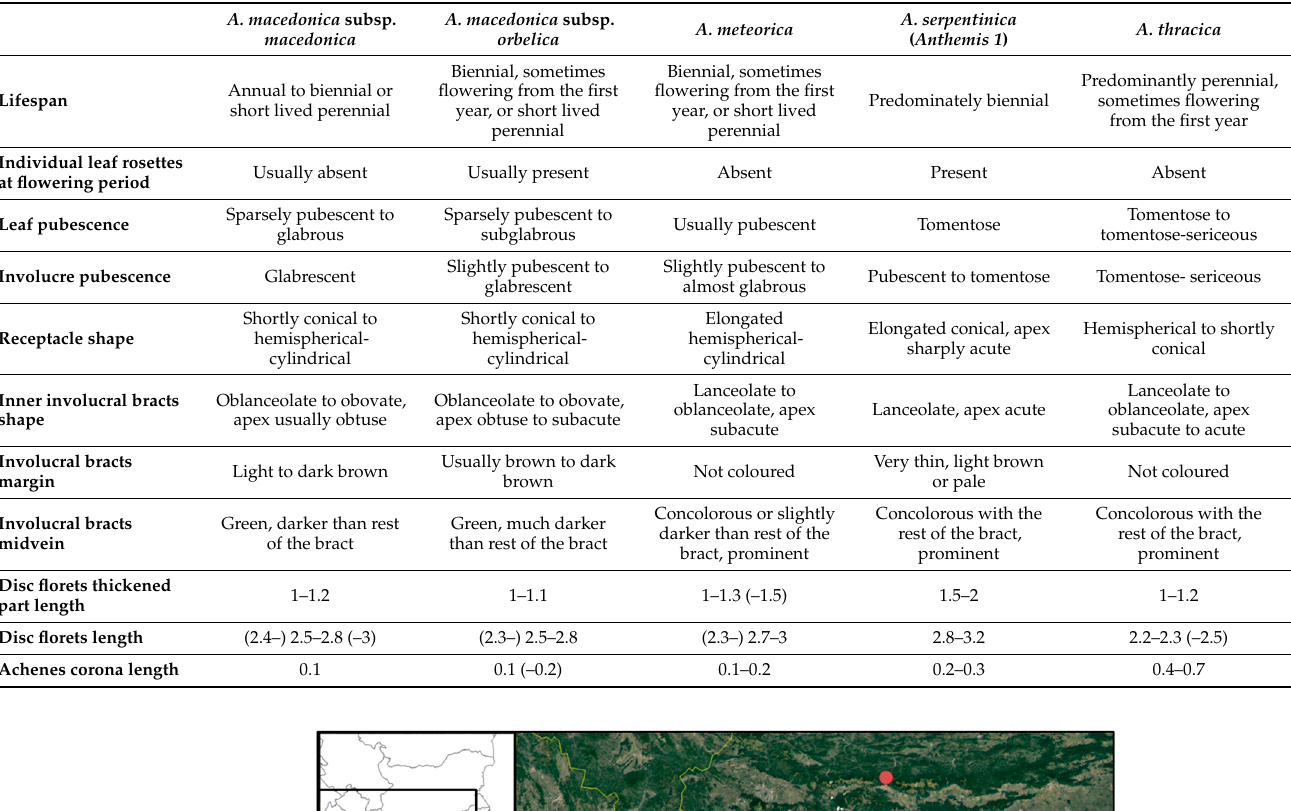
Table 3. Comparison of morphological features among five taxa of the Anthemis macedonica group. For A. macedonica subsp. stribrnyi, only the type was seen. Uncommon characteristic values are in parentheses. All measurements in mm.